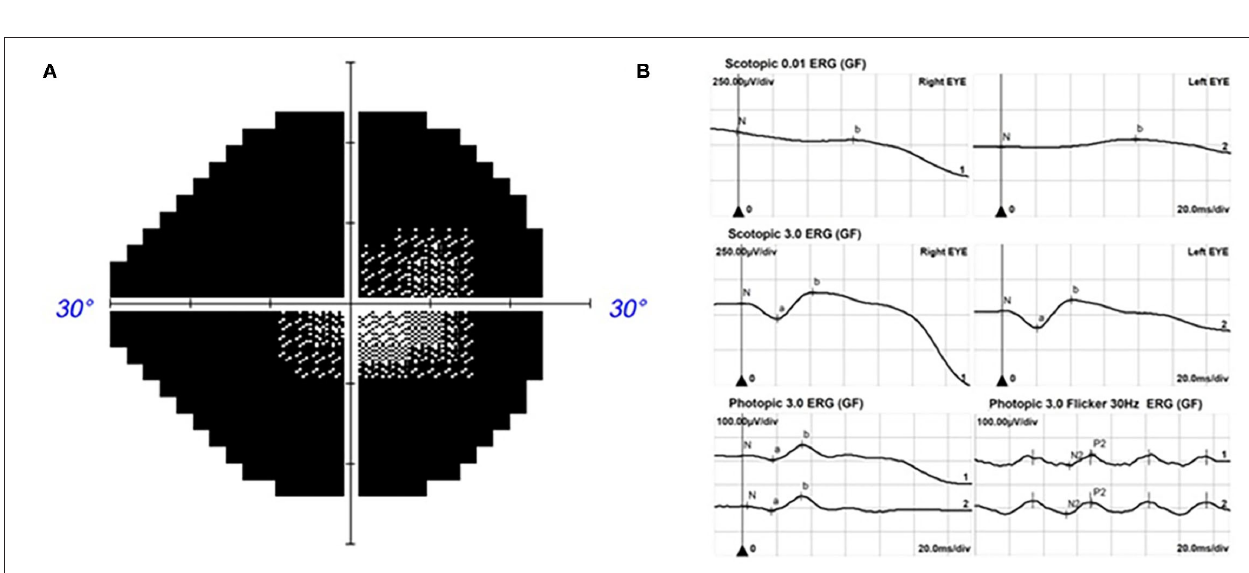
FIGURE 3 | The vision field and ERG for the proband. Kinetic perimetry presented a tubular visual field in the right eye (A) and diminished rod responses with mild damage in cone responses on ERG (B) .